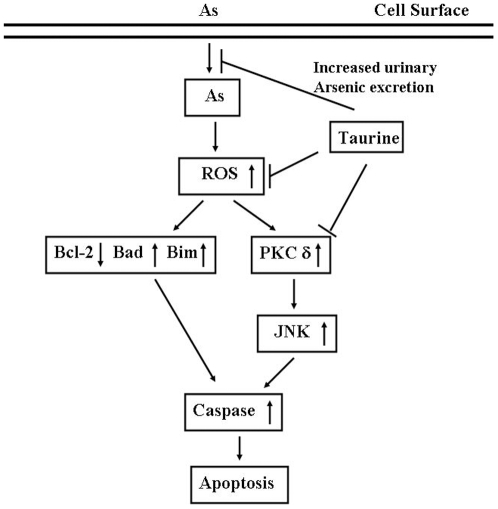
Schematic diagram of the NaAsO2 induced hepatotoxicity and its prevention by taurine.